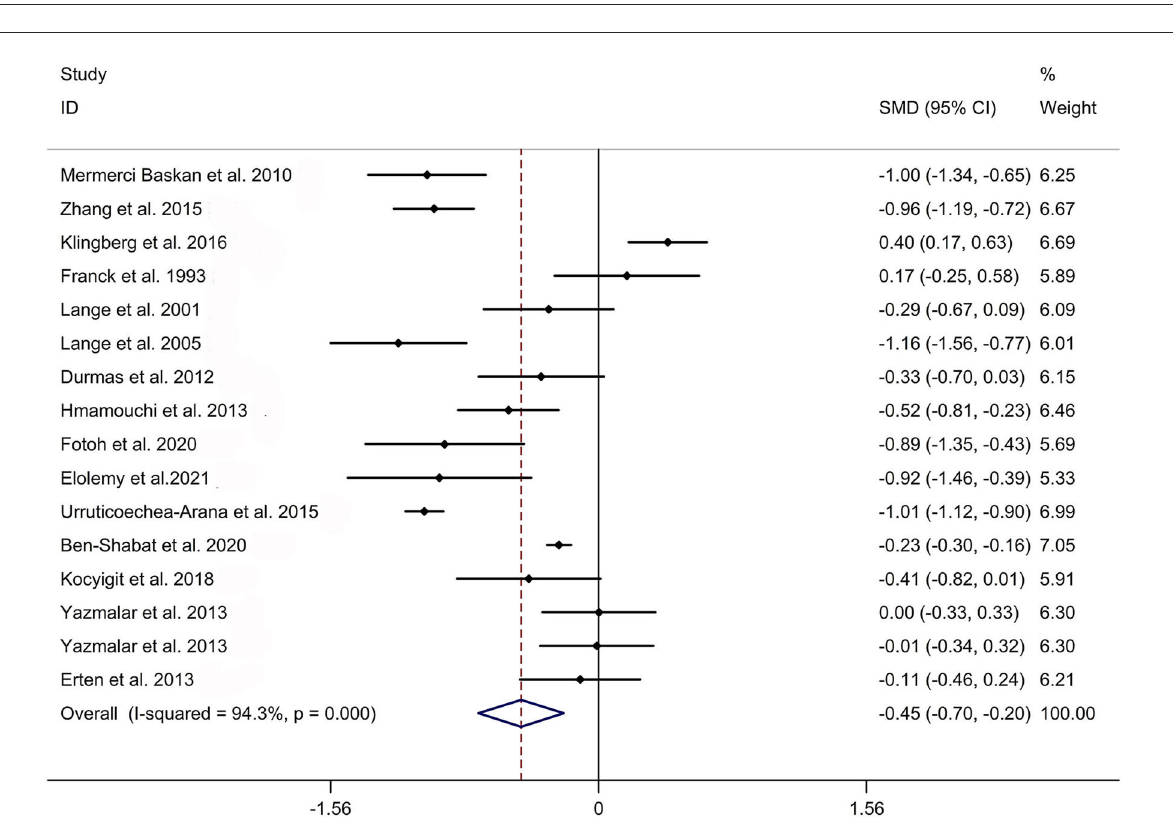
FIGURE2 Forest plot regarding comparison in peripheral 25OHD levels between AS and HC. AS, ankylosing spondylitis; HC, healthy controls; 25OHD, 25-hydroxyvitamin